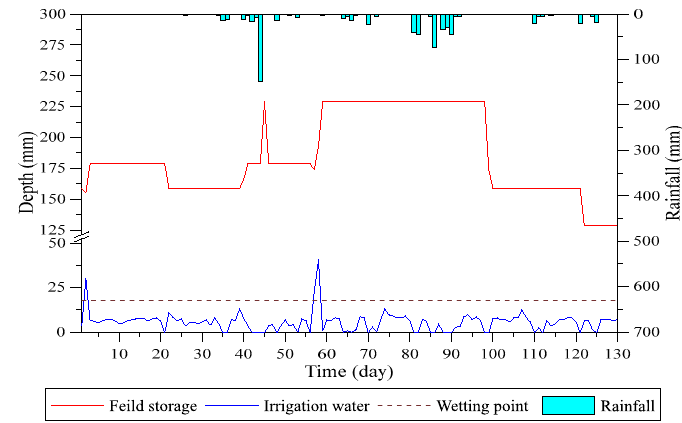
Figure 15. Simulation of block 1 under 30% reduction of planned irrigation water during the first crop season.